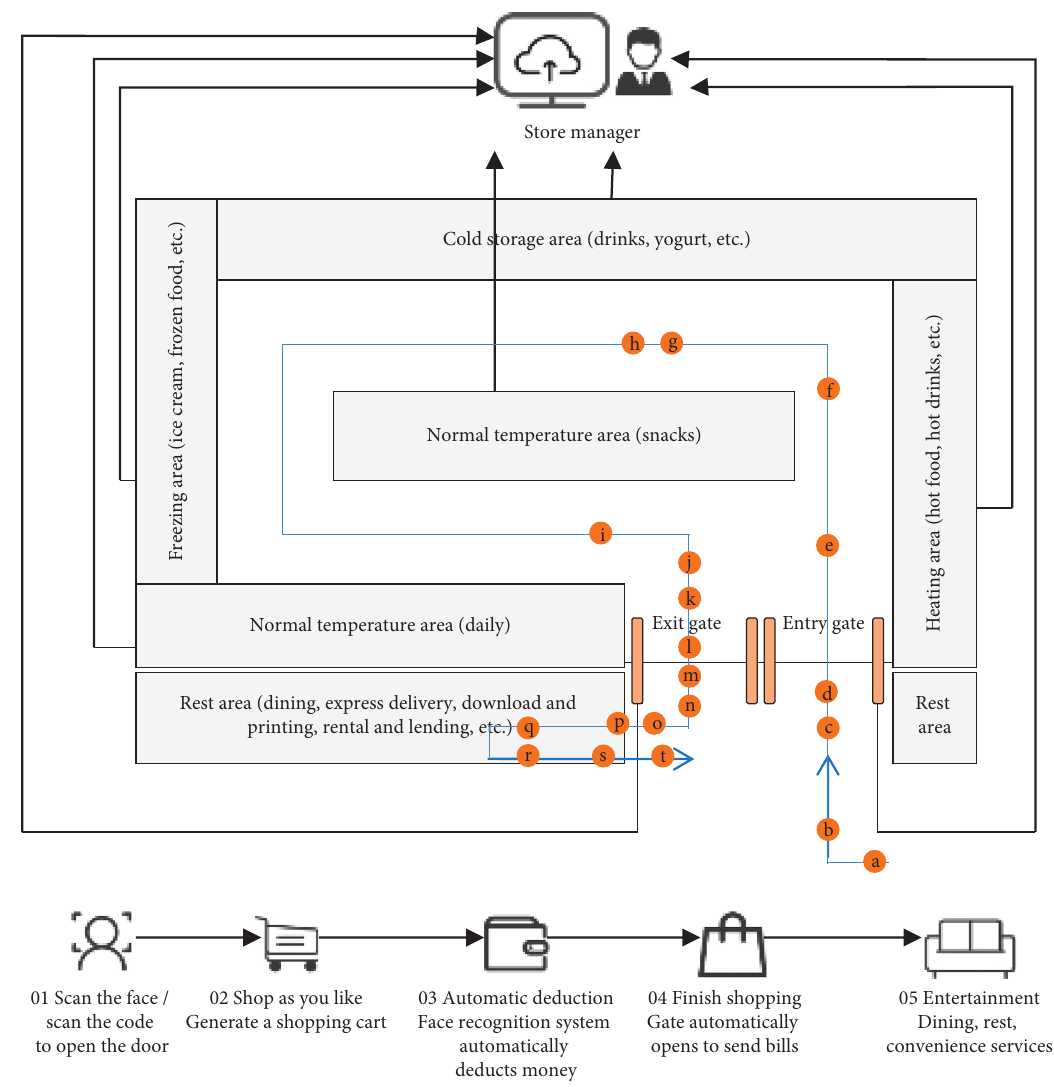
Figure 9: The main flowchart of the convenience store service